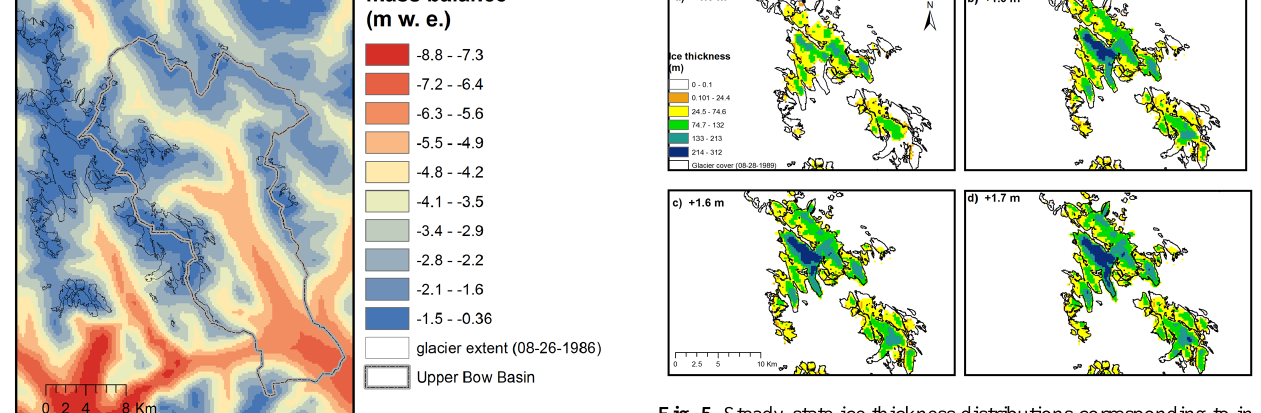
Fig. 5. Steady-state ice thickness distributions corresponding to in- creases (mw.e.yr − 1 ) applied to averaged 1979–2008 net mass bal- ance shown in Fig. 4. The numbers indicate the increases applied to averaged mass balance only within glacierized areas. Glacier cover extents were delineated from the Landsat image acquired 26 Au- gust